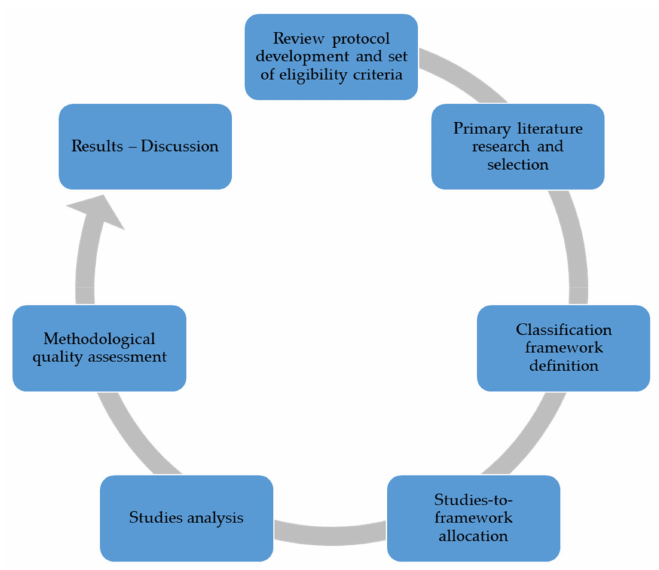
Figure 1. Steps of review